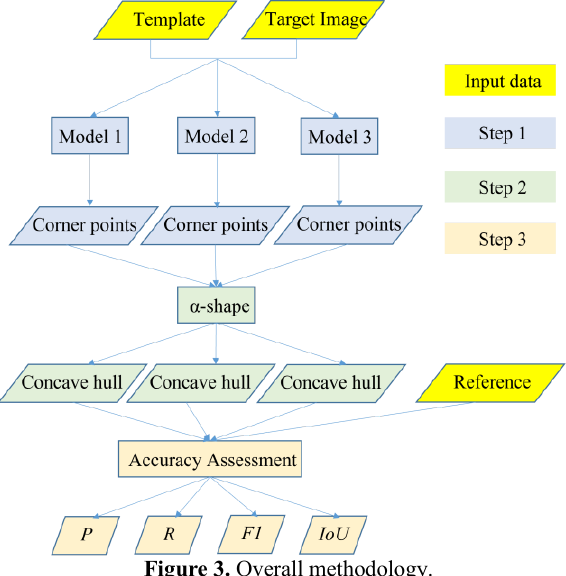
Figure 3. Overall